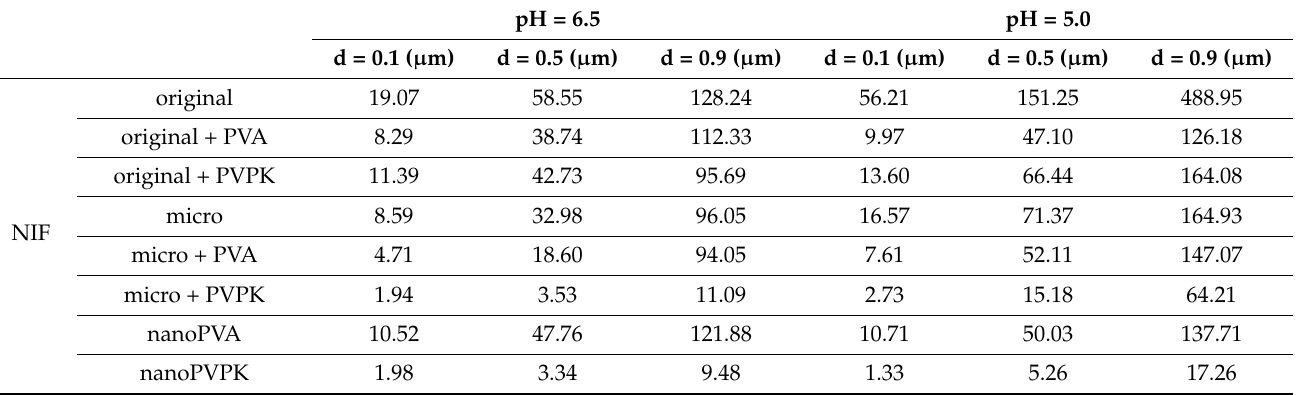
Table 5. Particle size distribution of the solid phase samples from the solubility measurements of niflumic acid .